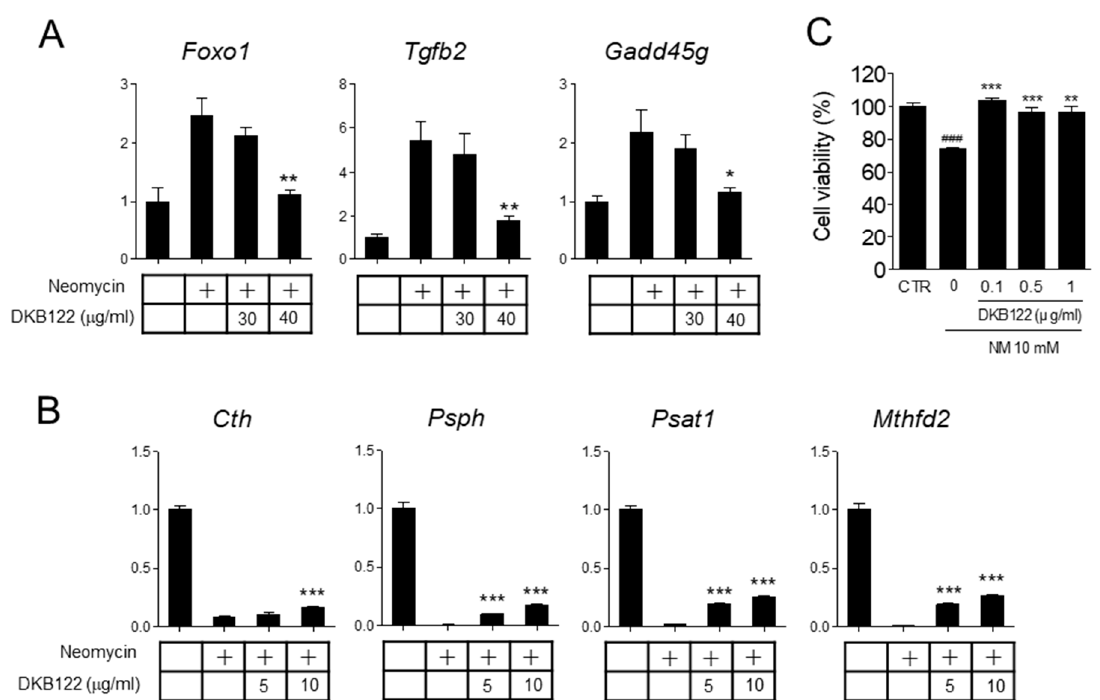
Figure 6. DKB122 rescued altered gene expression and improved viability in neomycin-treated